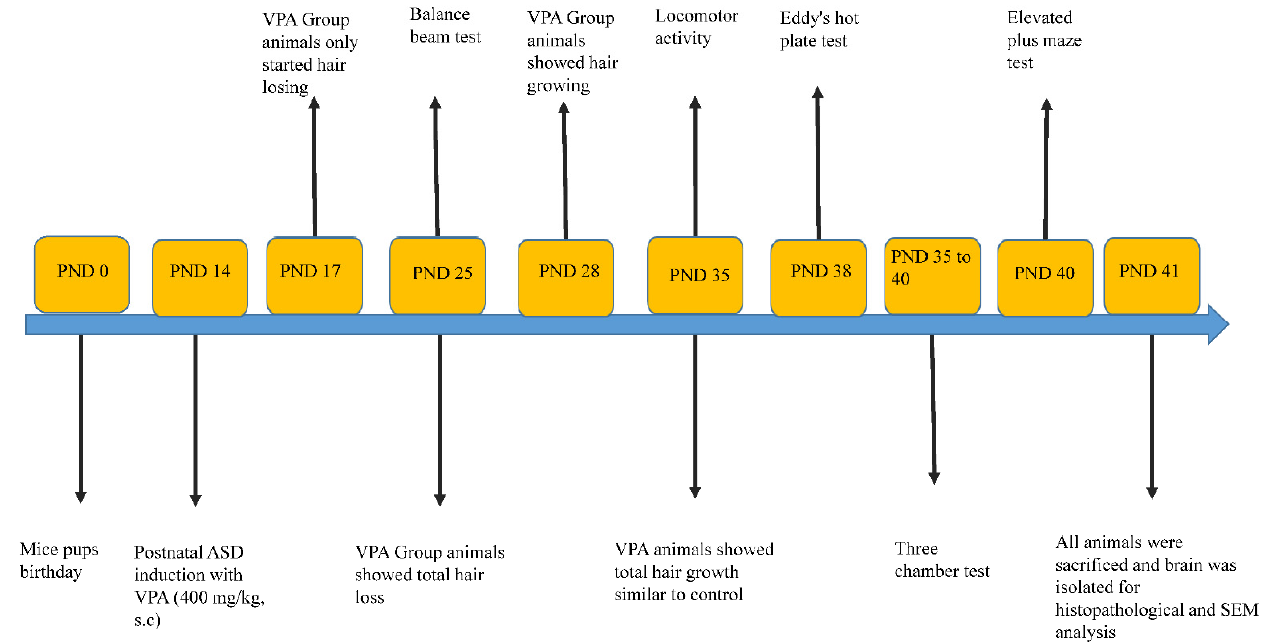
Figure 1. A clear timeline picture of study design including VPA injection, behavioral tests and, sample collection for histopathological, immunohistological and SEM analysis.